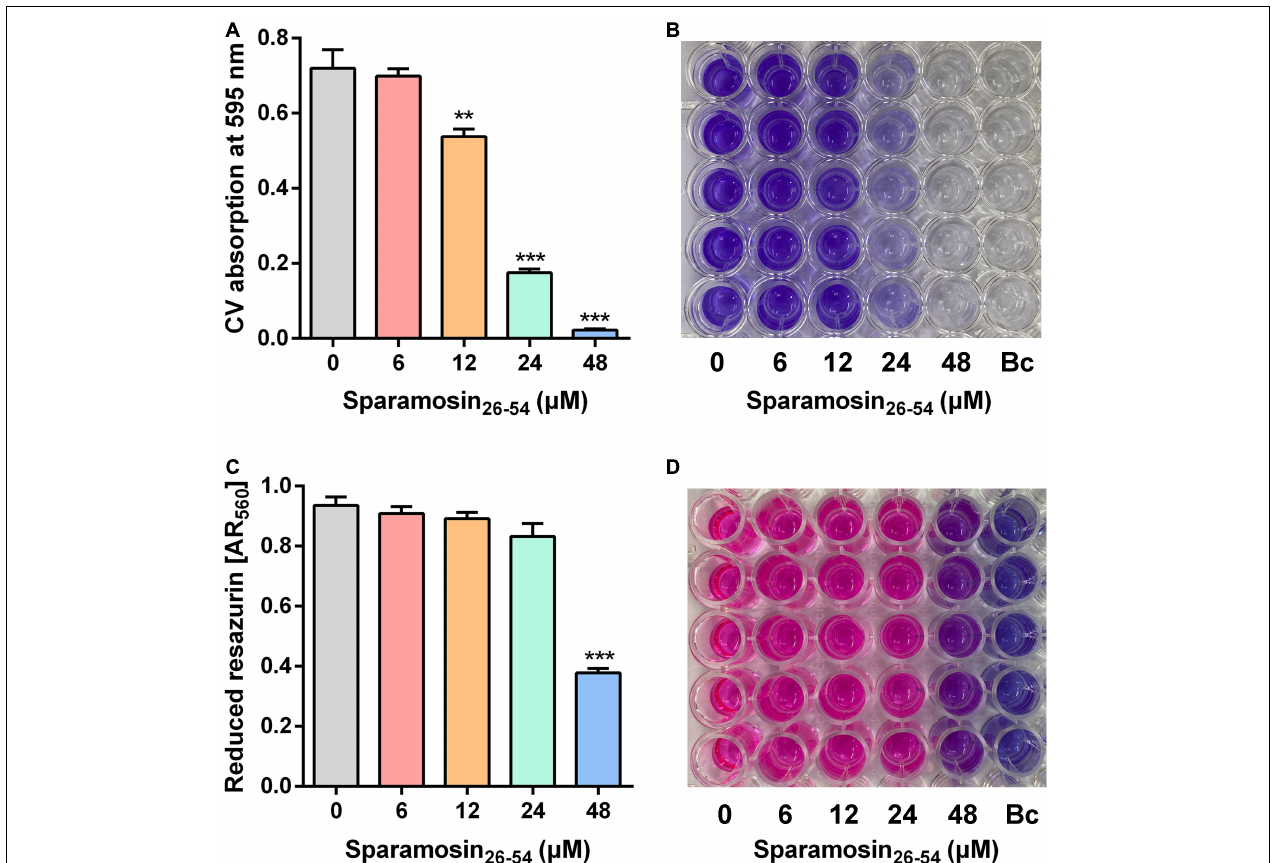
FIGURE 2 | The inhibitory effect of Sparamosin 26 − 54 against C . neoformans biofilm. (A,B) The inhibitory effect of Sparamosin 26 − 54 on the formation of C . neoformans biofilm. The biofilm mass was quantified by CV staining, and the absorbance at 595 nm was measured. Bc, blank control. (C,D) The inhibitory effect of Sparamosin 26 − 54 against the preformed biofilm of C . neoformans . The amount of reduced resazurin (resorufin) was determined by measuring the absorbance at 560 nm, and the residual amount of oxidized resazurin was quantified by measuring the absorbance at 620 nm. The corrected A 560 value (AR 560 ) was calculated using the following formula: AR 560 = A 560 − (A 620 × R O ) and R O = AO 560 /AO 620 , where A 560 and A 620 are sample absorbance and AO 560 and AO 620 are the absorbance of RPMI-MOPS medium containing 0.1 mM resazurin. Bc, blank control. Data represent mean ± standard error of mean from three independent biological replicates. Significant difference between control group and Sparamosin 26 − 54 treatment group was indicated by asterisks as ** p < 0.01; *** p <